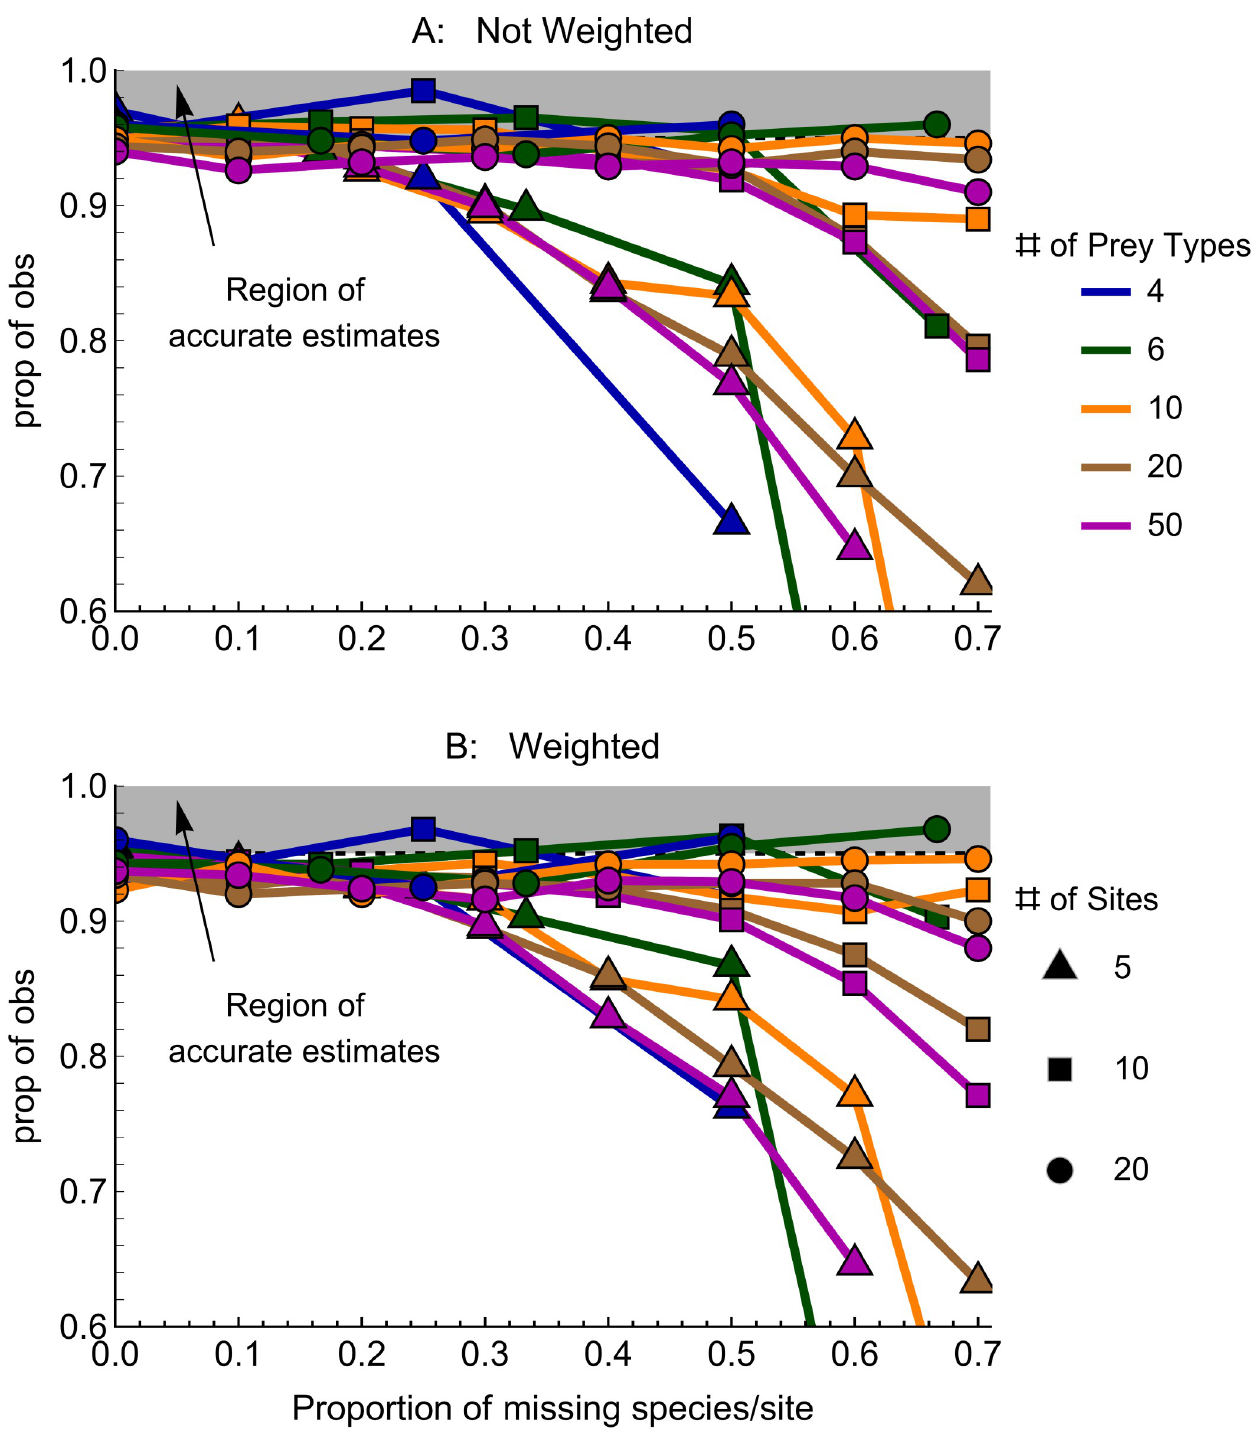
Fig 4. IPA gives accurate estimates when there are fewer prey types, smaller proportions of missing types per site, and more sites. Accuracy of weighted and unweighted bootstrapped estimates of IPA are estimated for simulated data. Confidence intervals were estimated by bootstrapping 100 replications of each combination of parameters. The Y axis is the proportion of results that are within 95% confidence intervals—thus, higher values are better. The gray region shows the proportion of results inside each 95% confidence interval—i.e. these are accurate estimates. There was no difference in accuracy between weighted and unweighted